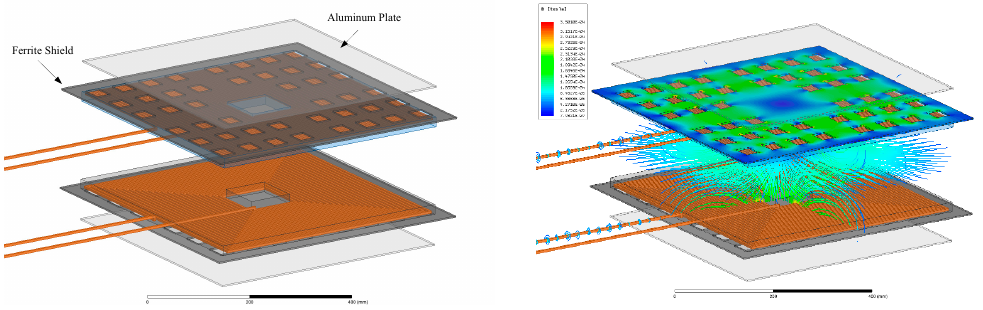
Figure 7. Finite element model of shield coupling coils.